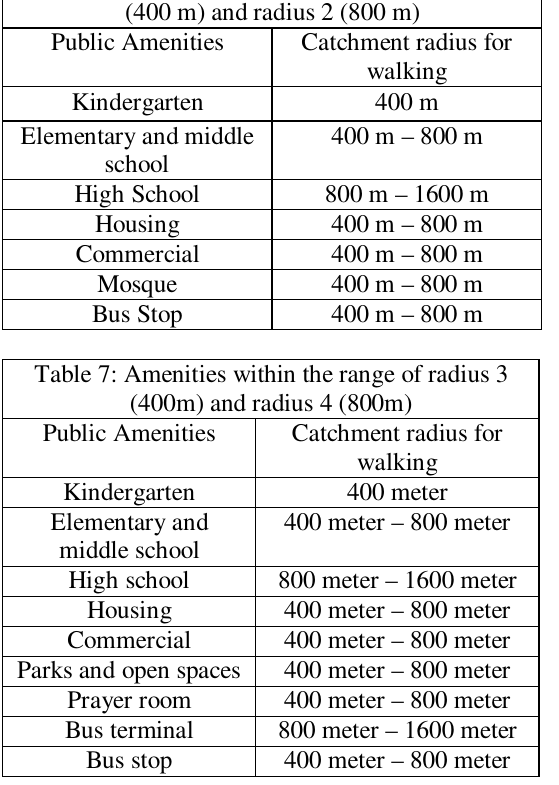
Table 6: Amenities within the range of radius 1 (400 m) and radius 2 (800 m)